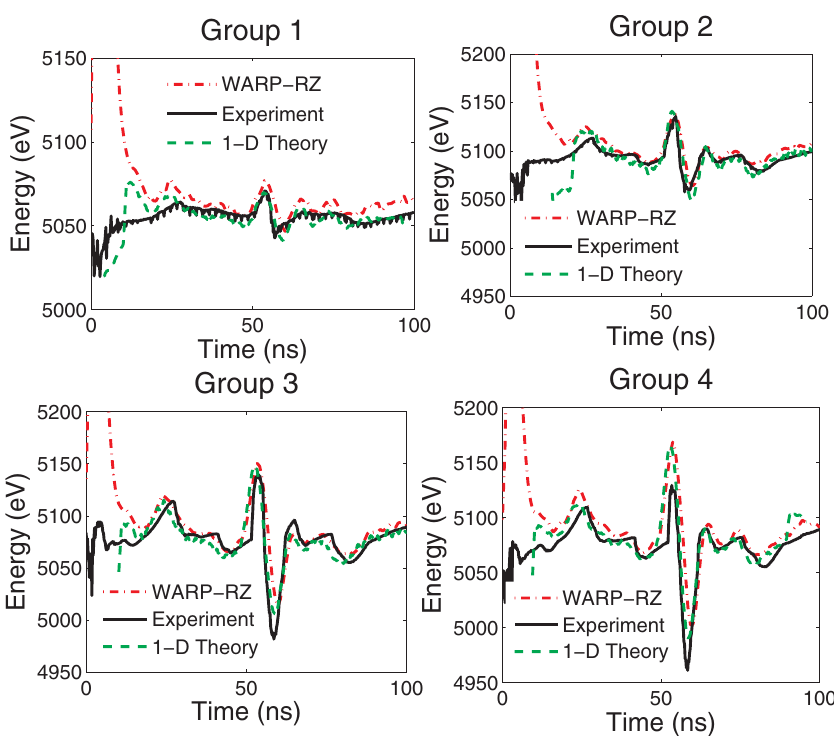
FIG. 5. (Color) Comparisons of the profiles of the mean energy for the experiment results, WARP simulation results and one- dimensional cold fluid theory.